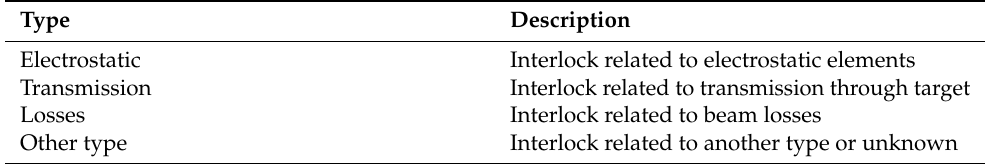
Table 2. The different types of interlocks in the